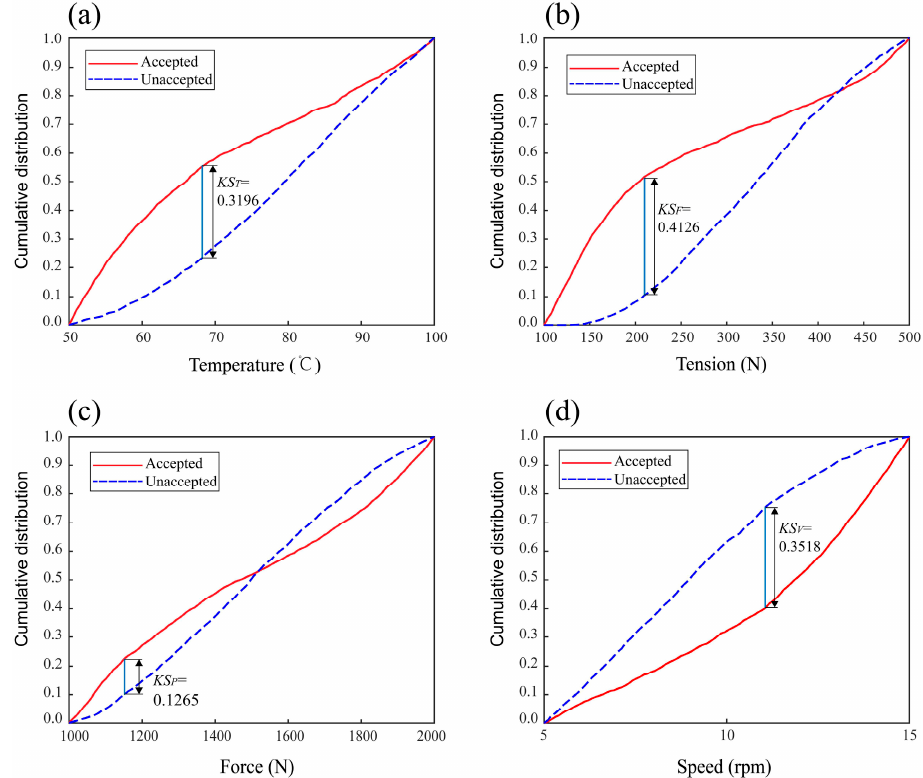
Figure 7. Results of GMSA for the tensile strength model. ( a ) Temperature, ( b ) Tension, ( c ) Force, ( d ) Speed.